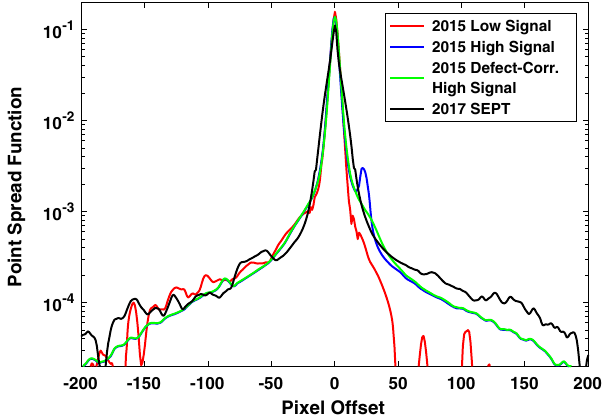
FIG. 16. Zero-order “ direct ” PSF functions obtained from 3 different datasets obtained in 2015 (low and high FEL radiation signals) and September 2017. The green line labeled “ Defect- Corr. ” includes a subjective correction of a CCD damage defect affecting the high radiation signal 2015 PSF data at a pixel offset of þ 30 .